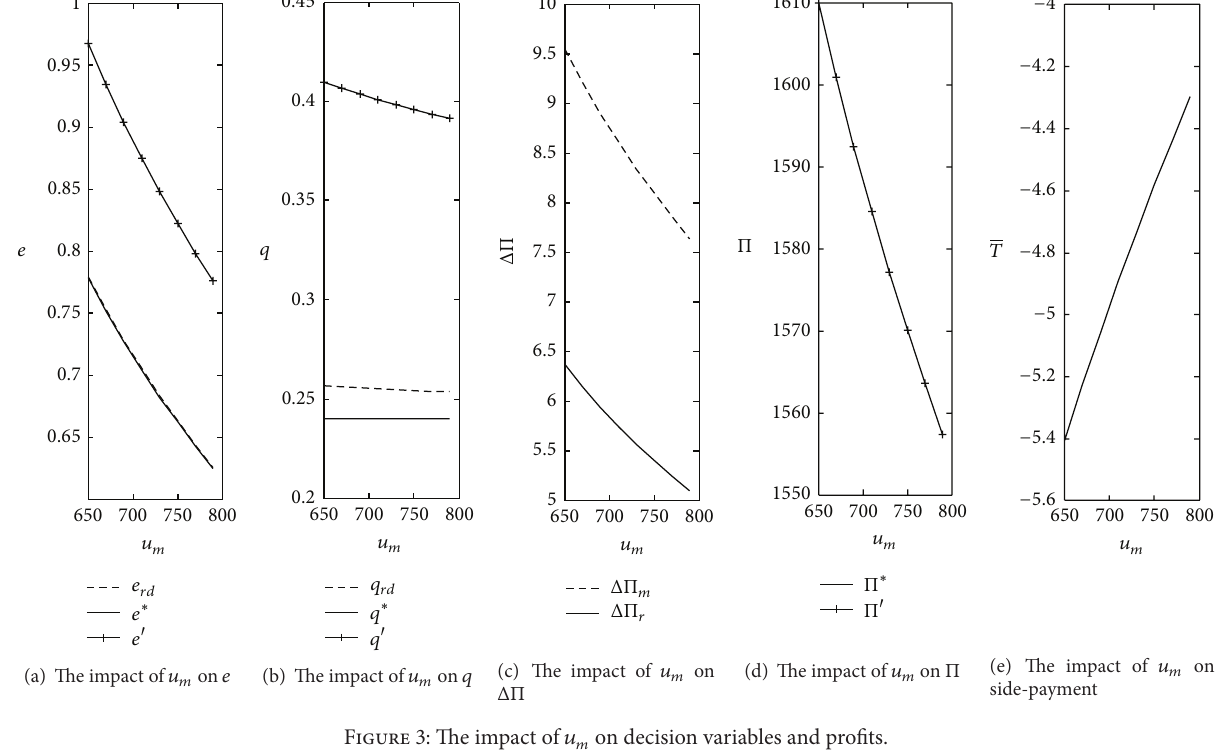
Figure 3: The impact of 𝑢 𝑚 on decision variables and profits.